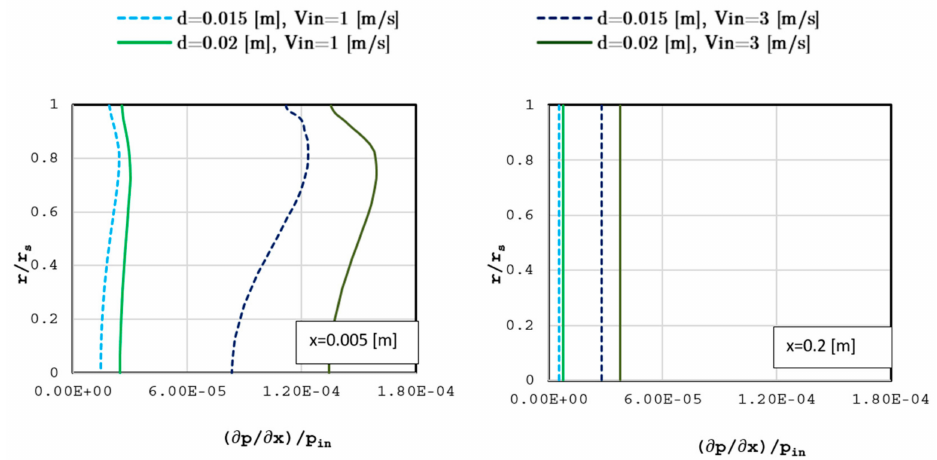
Figure 8. Results of the conjugate heat transfer analysis Pressure profiles at di ff erent